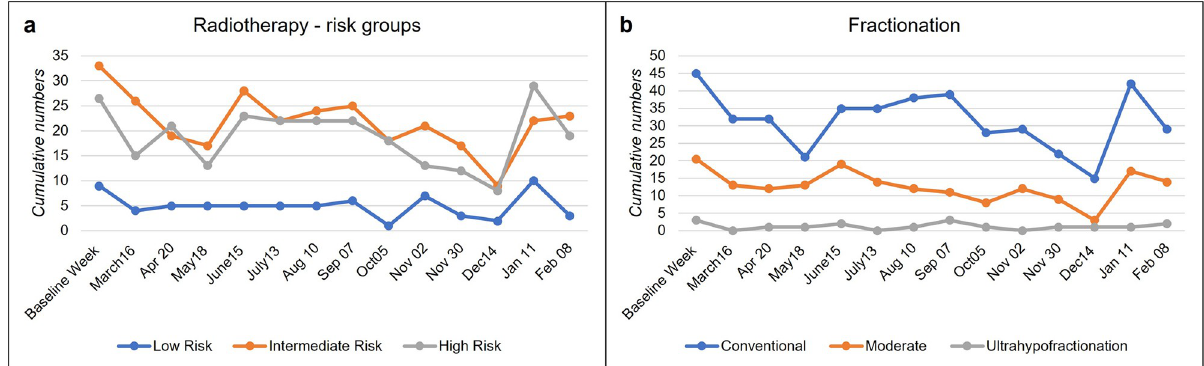
Fig 4. Changes in radiotherapy. (A) Cumulative numbers of patients treated with radiotherapy with division in PCa risk groups and type of fractionation (B).